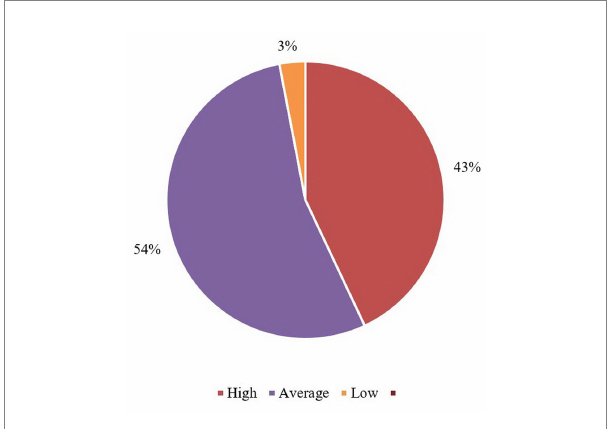
FIGURE 3 Answers to the question: do you use mobile applications